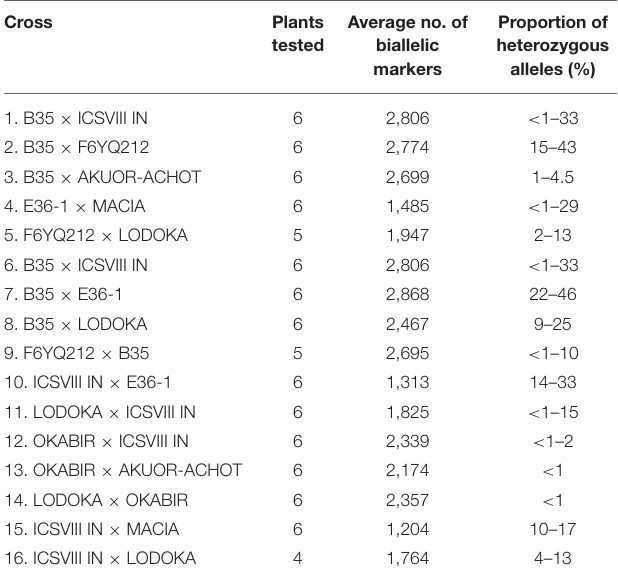
TABLE 4 | Confirmation of hybridity among the fourth filial generation (F 4 ) progenies using Striga number progress (SNP) markers. Cross Plants